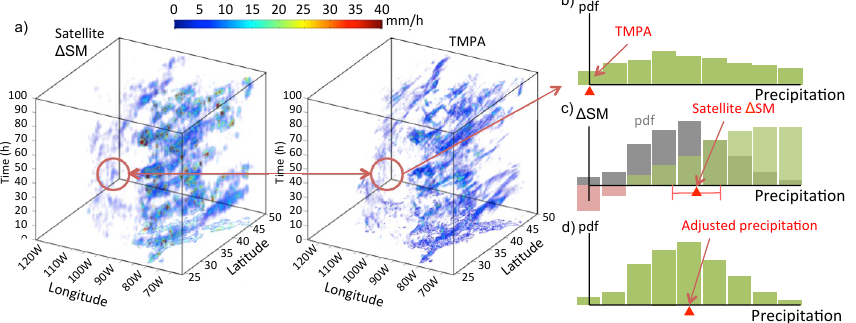
Figure 2. Schematic for the strategy for processing prior and posterior probability densities in the particle filter. The missing rainfall event in TMPA (circled in the right panel of a , correspond to red triangle in b ) against satellite signals as detected by AMSR-E/LSMEM (cid:49) SM (circled in the left panel of a , correspond to red triangle in c ), and recovered by assimilating AMSR-E/LSMEM (cid:49) SM into TMPA (marked by red triangle in d ).